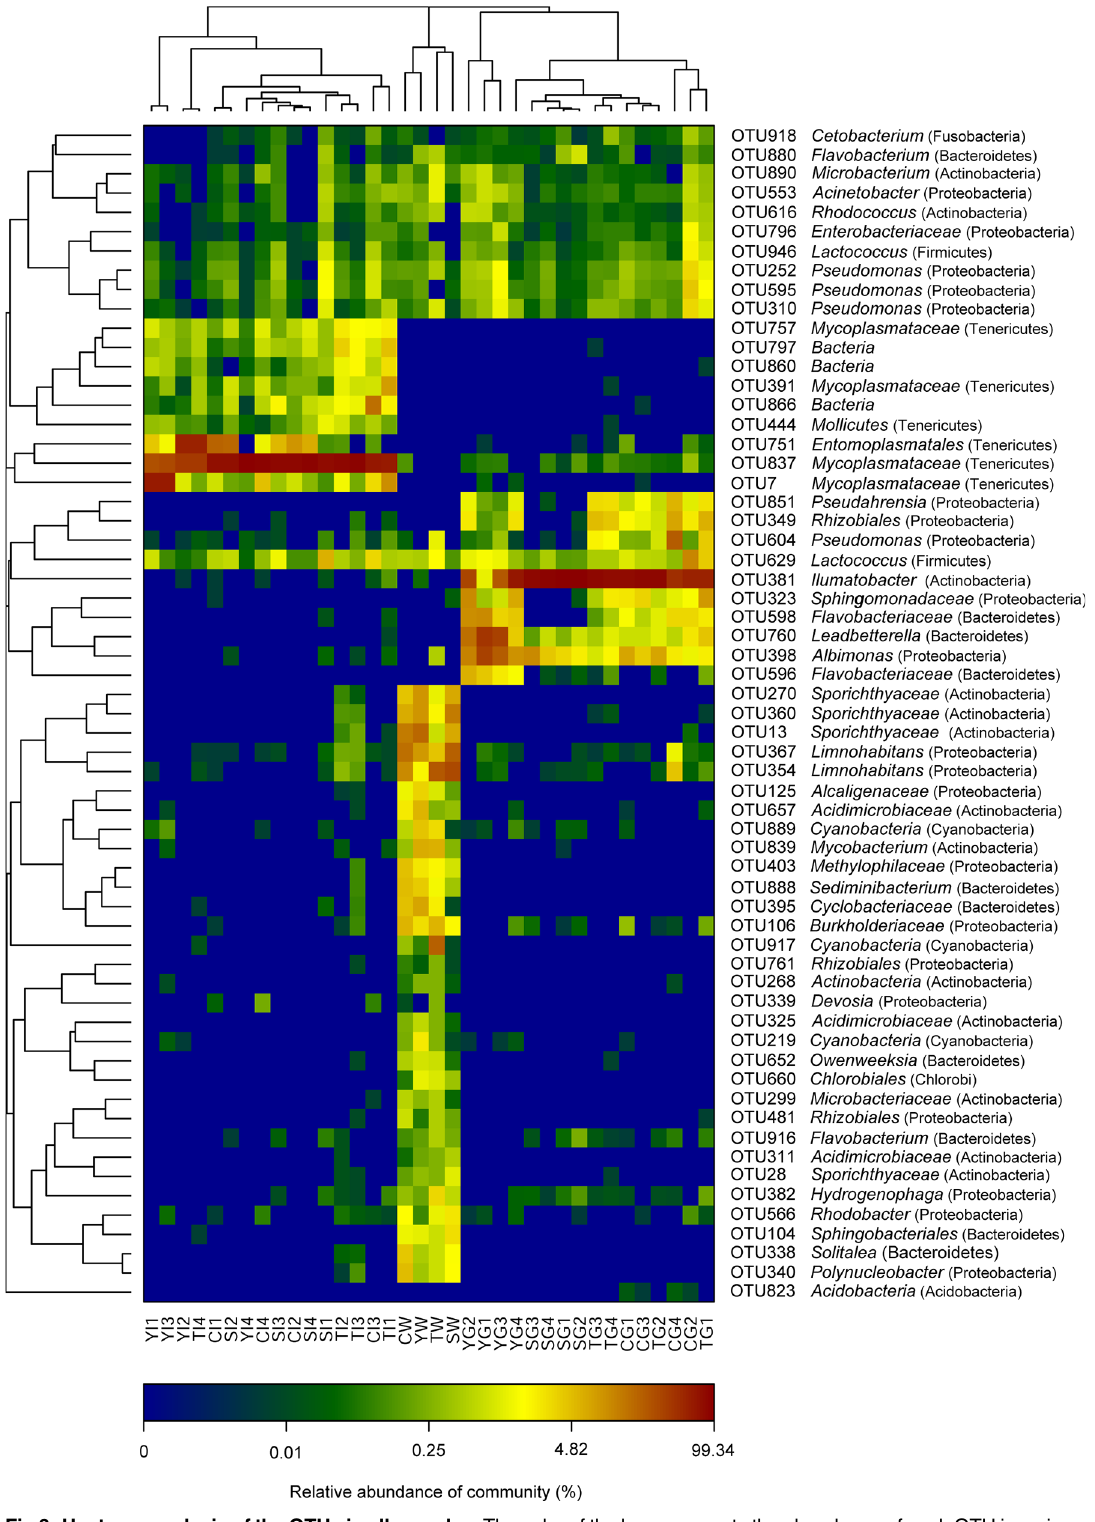
Fig 3. Heatmap analysis of the OTUs in all samples. The color of the bar represents the abundance of each OTU in a given sample. The affiliation of each OTU is indicated on the right.